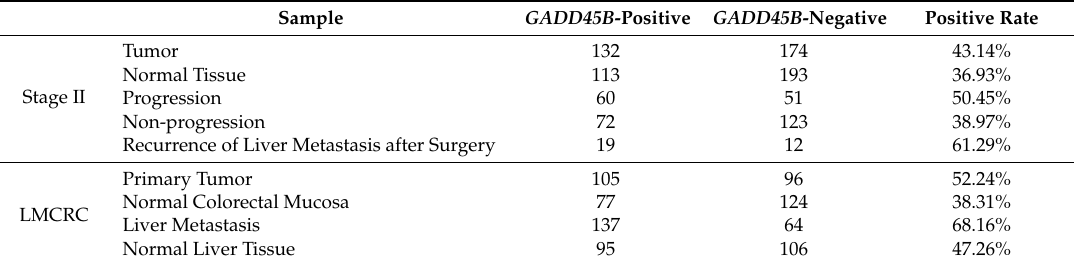
Table 1. The GADD45B expression pattern in different samples by immunohistochemical (IHC) staining.